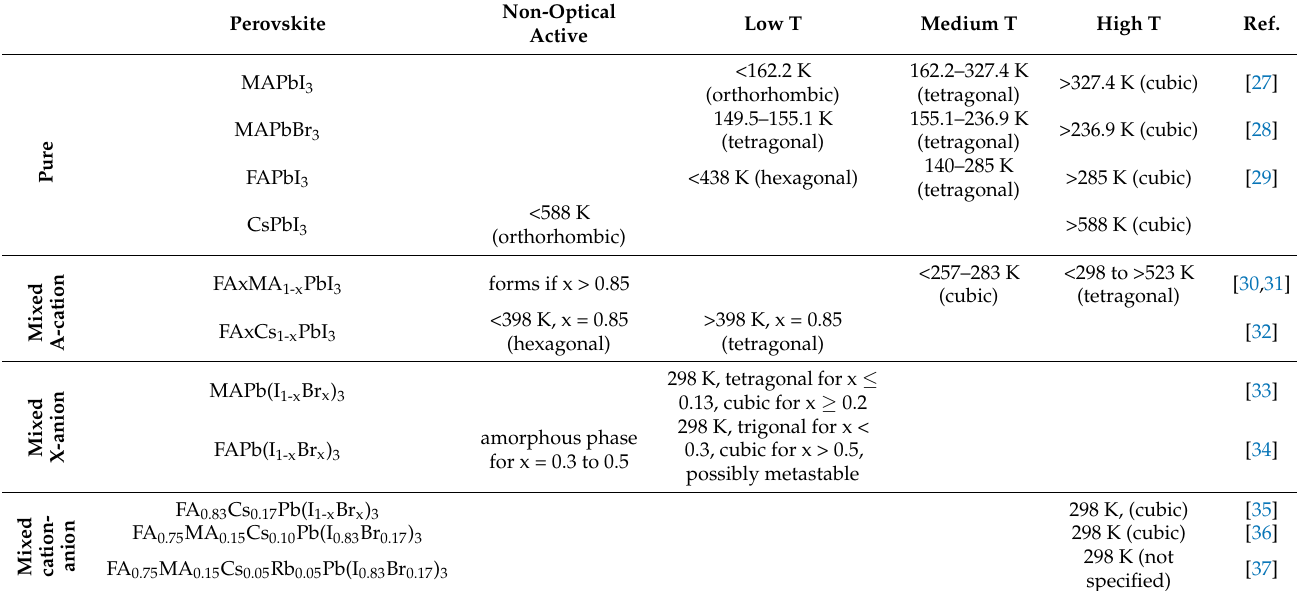
Table 1. Summary of the different crystal structure depending on the composition and the temperature of the per- ovskite